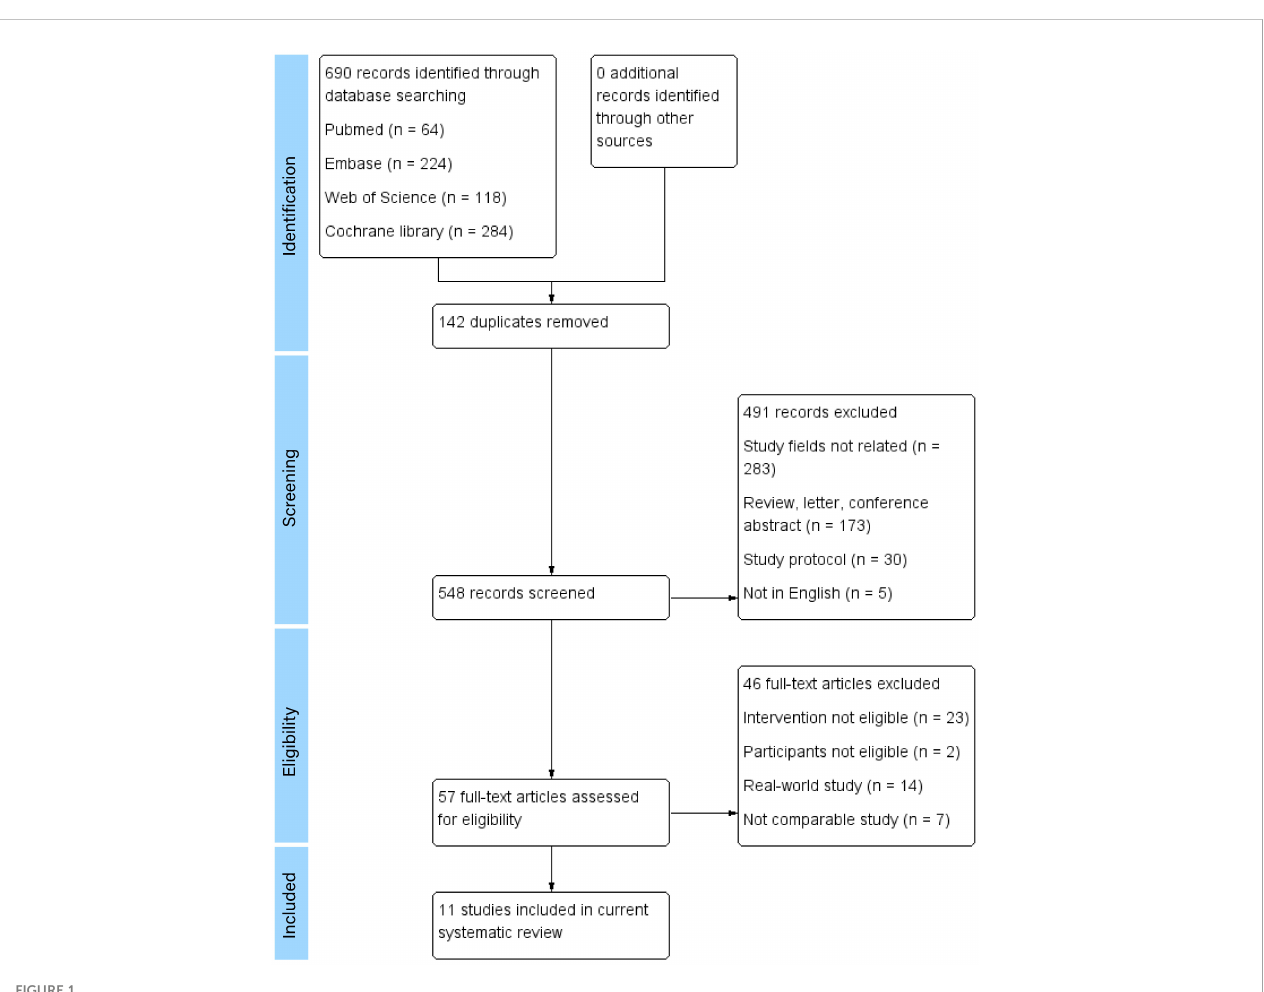
Figure 2. The criteria of objective clinical response were displayed in Additional fi le 2.